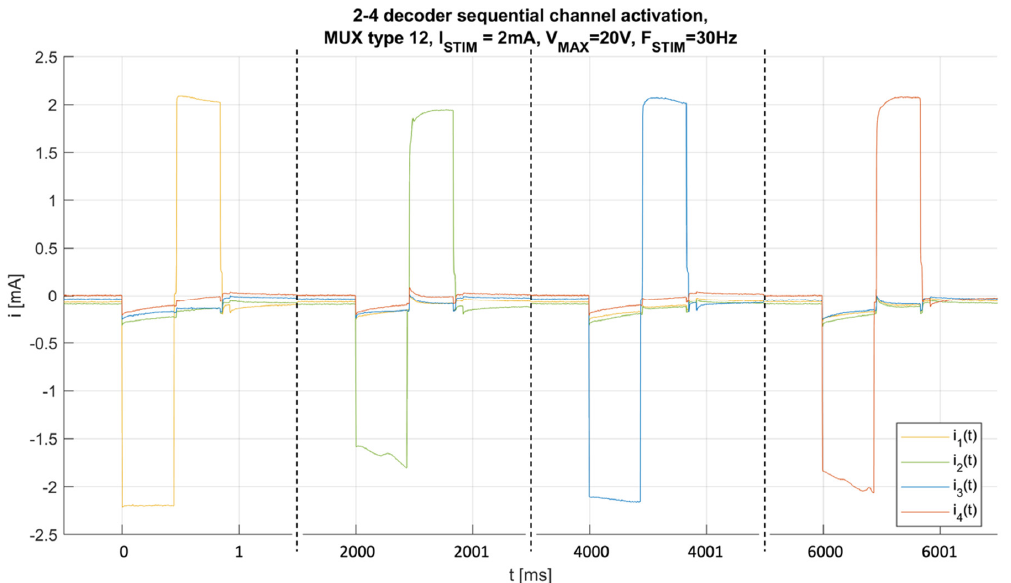
Figure 11. Current propagation through the OECT-based demultiplexer circuit measured on the testbed for validation of the switching capabilities of printed circuits. The four signals represent the four currents measured at the different outputs of the 2–4 demultiplexer circuit when a 2 mA current controlled pulse train with a pulse width of 400 µs was supplied at the input. The logic signals were changing the state of the demultiplexing unit every 2 s.